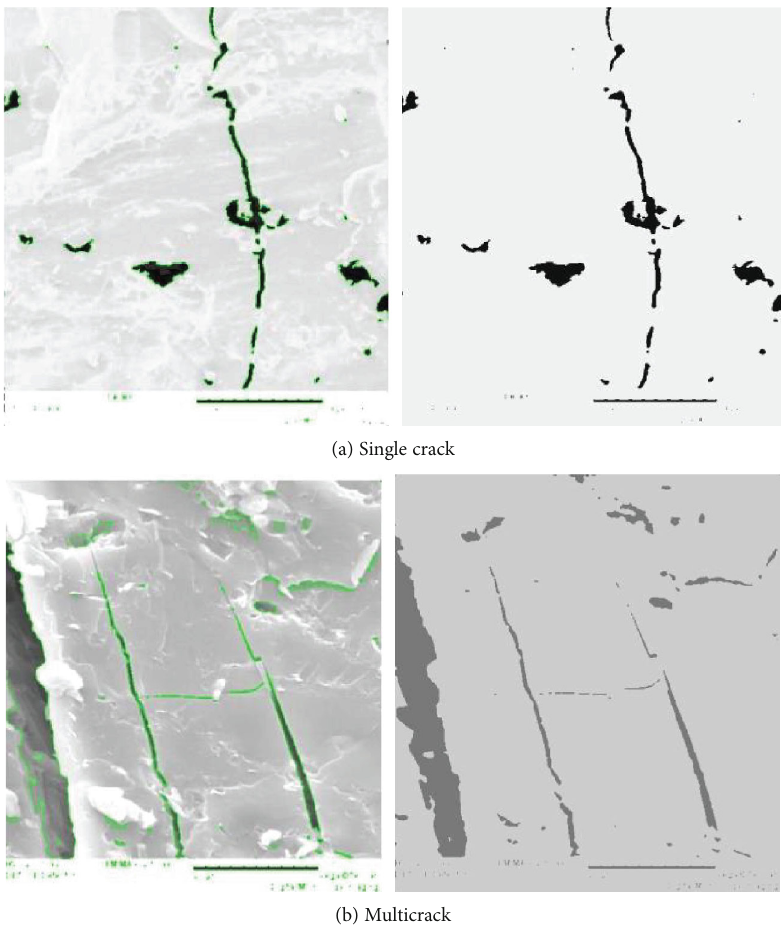
Figure 3: Segmentation of the image by the improved C-V model (4000 times